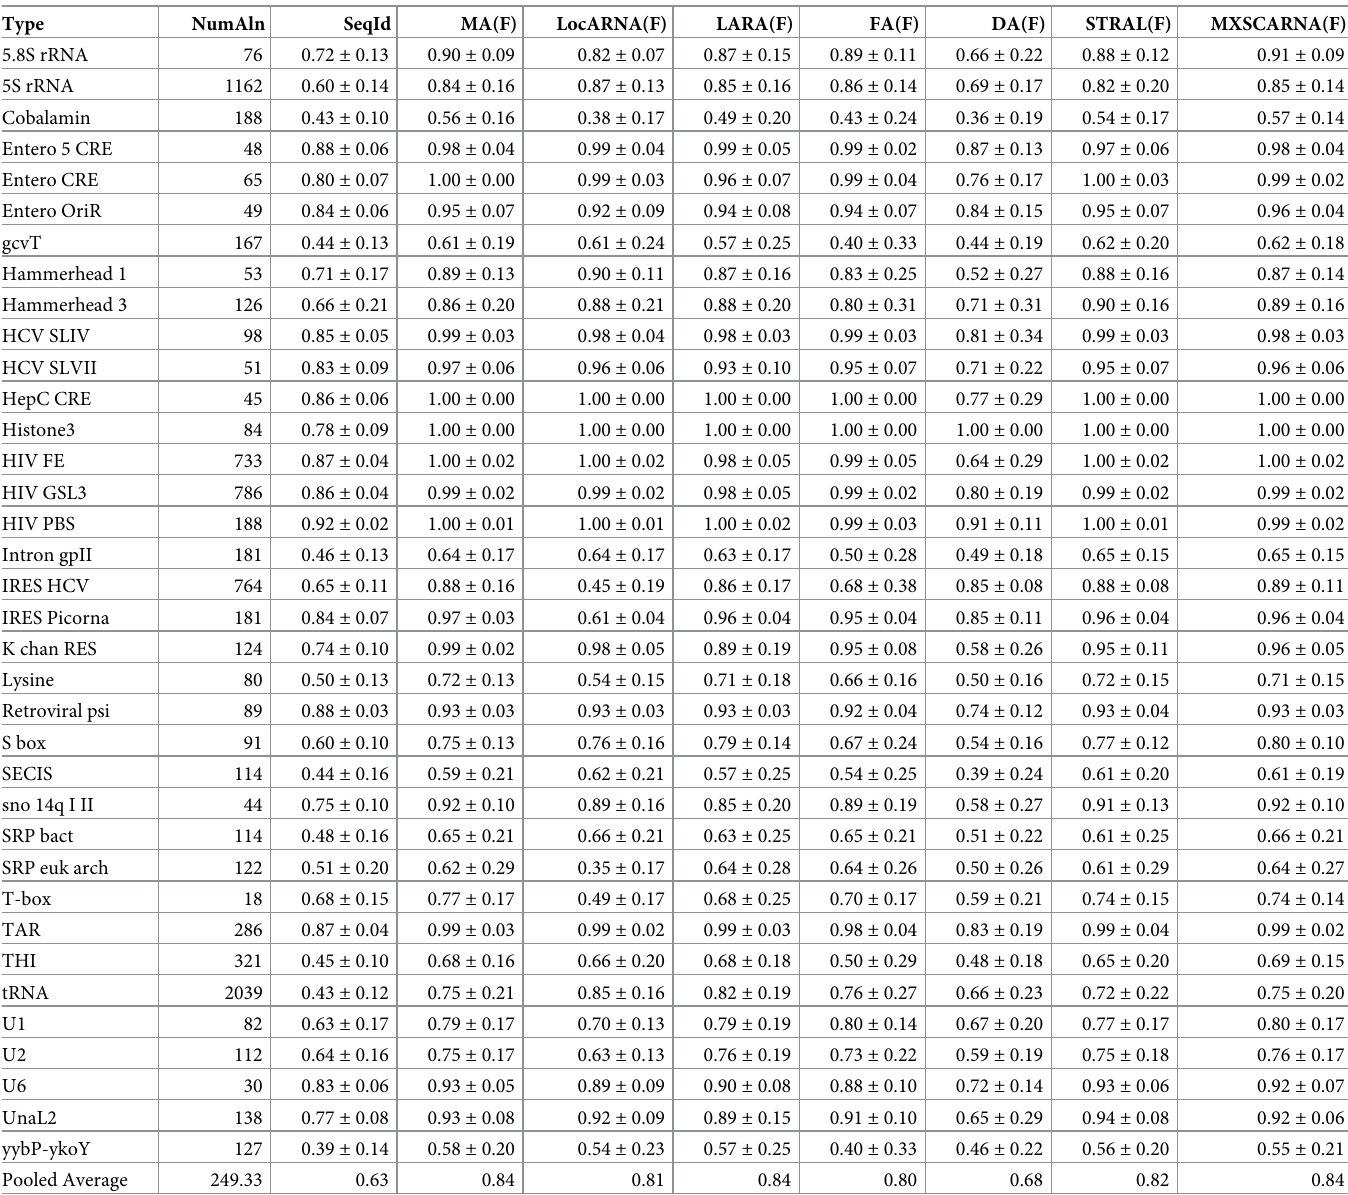
Table 4. F1 scores for pairwise global